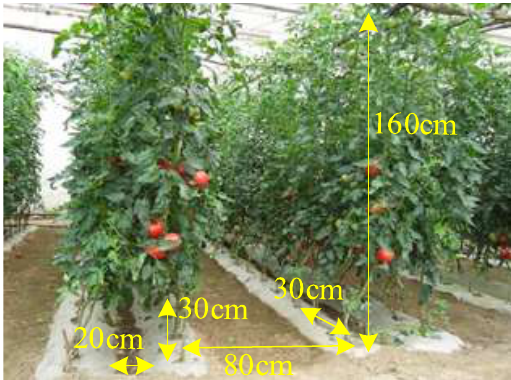
Figure 1. Schematic diagram of tomato planting mode.